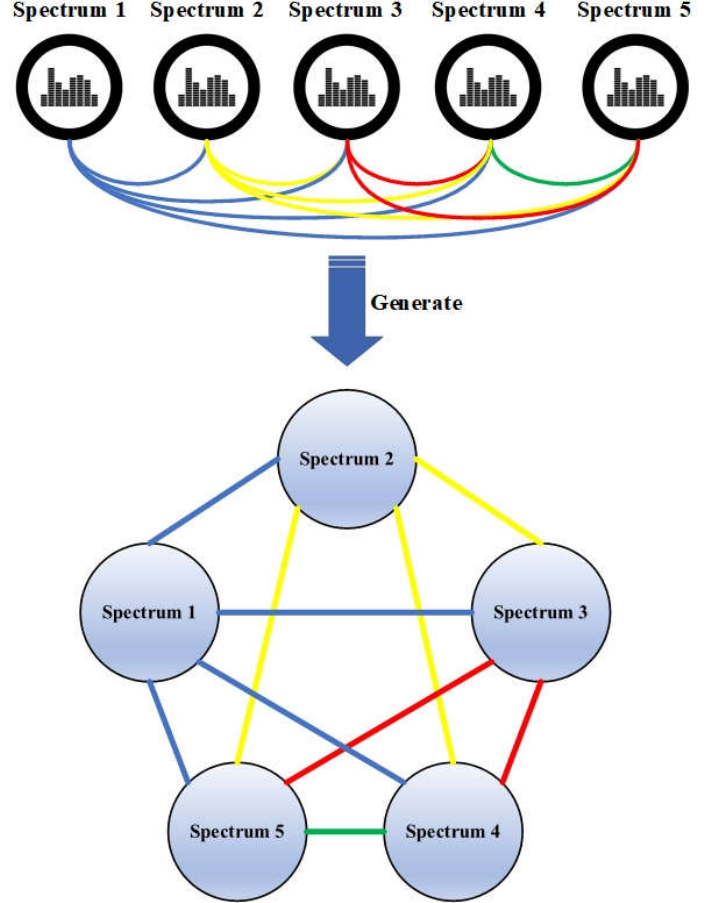
Figure 2. Network of spectra for a single document. Each line connecting two spectra represents a correlation coefficient of the two spectra. The different colors of edges are used to distinguish between different edges among nodes. The colors of the edges are used to distinguish the relations among the spectrums.